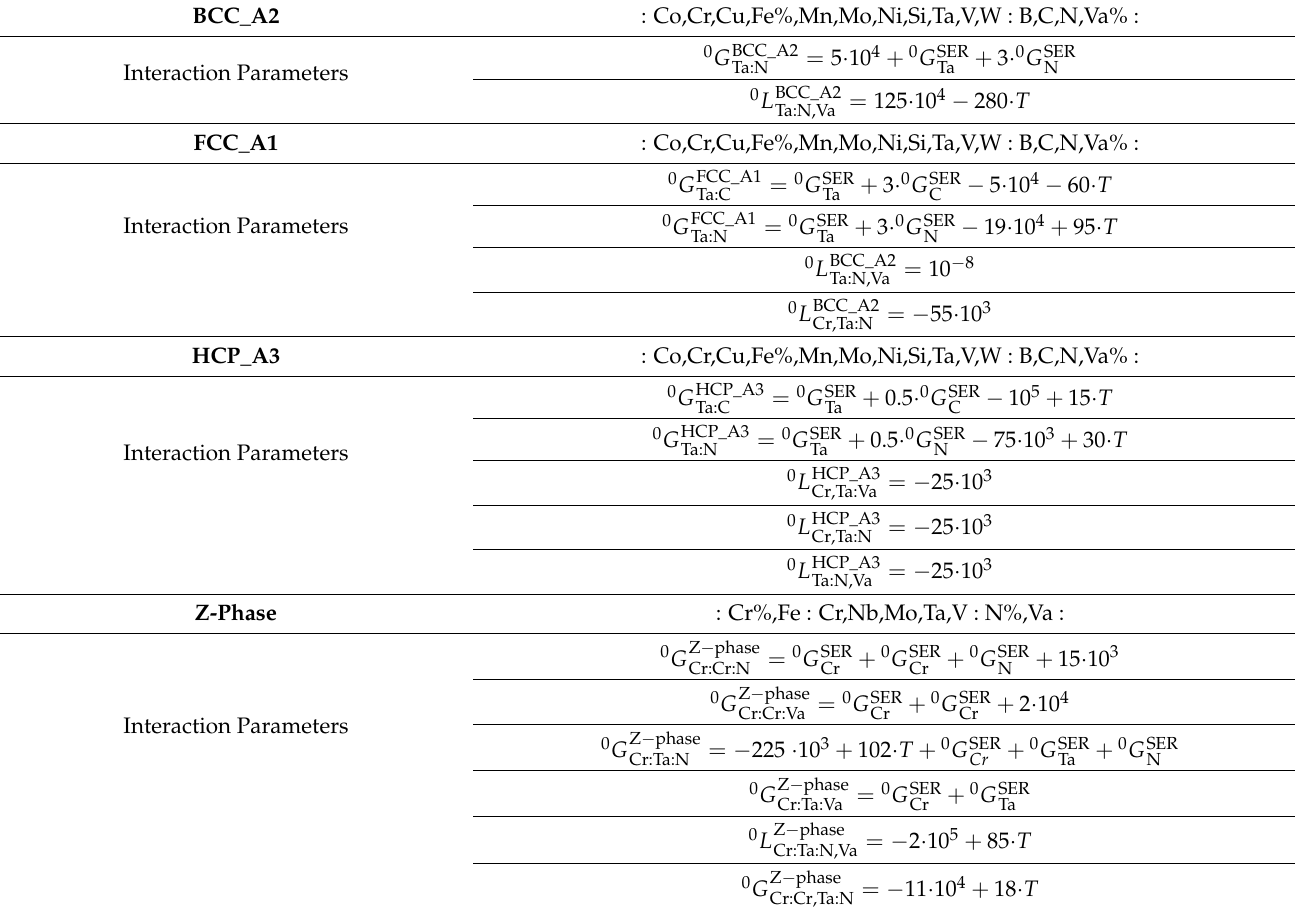
Table 2. Revised sublattice descriptions and thermodynamic interaction parameters with Ta (this